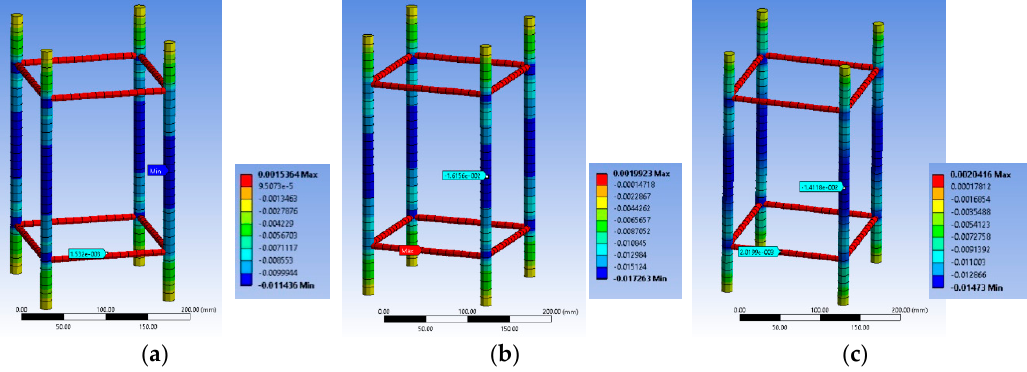
Figure 7. Variation of ε stirrup_max , ε long_mid and ε long_min for specimen ( a ) BS1C1C; ( b ) BS1C3C and ( c ) BS1C5C.